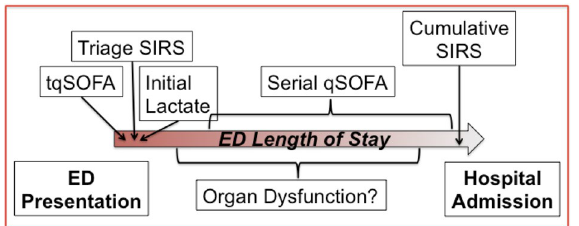
Figure 1. Modified schemata for ED operationalization of clinical and laboratory criteria to detect patients with